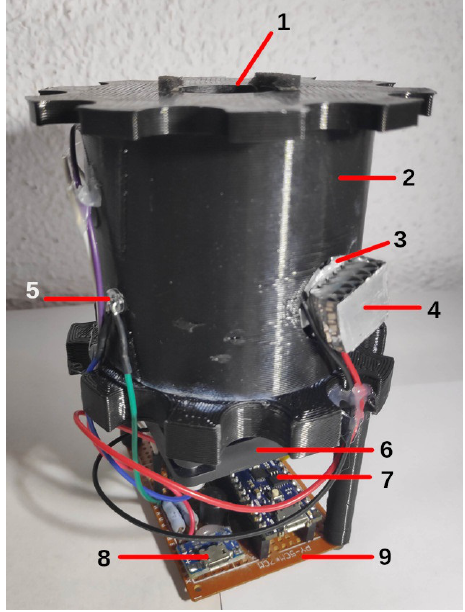
Figure 7. Part-wise declaration of the inner support: (1) test-tube support, (2) inner support, (3) UV LED, (4) heat dissipator, (5) transmittance LED, (6) stirrer motor, (7) Arduino Nano Every, (8) 5 V connector and (9)